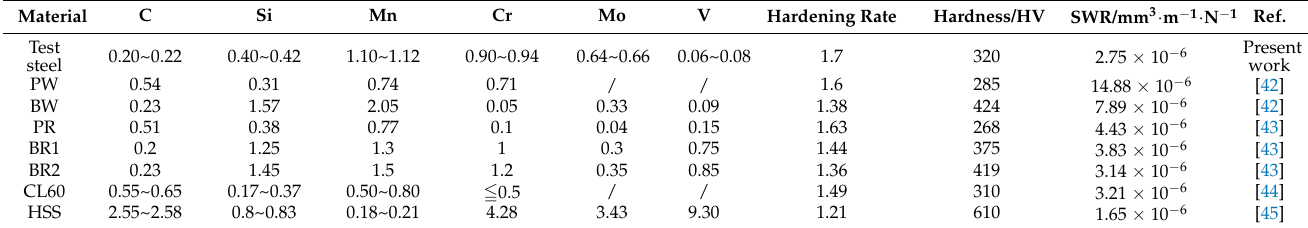
Table 8. SWR data and hardness of wear-resistant materials for railway reported under rolling–sliding wear of 10% slip ratio.